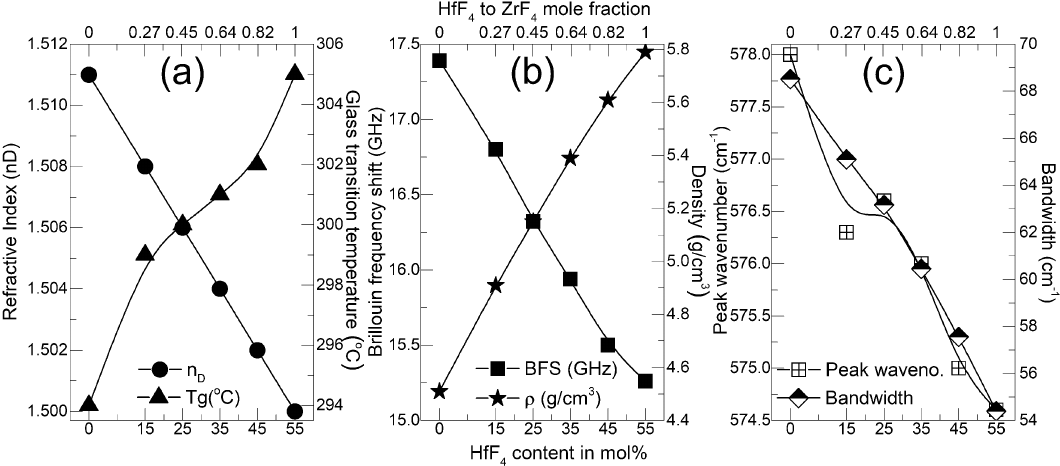
Figure 1. ( a ) refractive index (n) (left axis), glass transition temperature (Tg) (right axis), ( b ) Brillouin frequency shift (BFS) (left axis), density ( ρ ) (right axis) and ( c ) terminal fluorine Raman peak vibrational frequency (left axis), terminal fluorine Raman peak bandwidth (right axis).